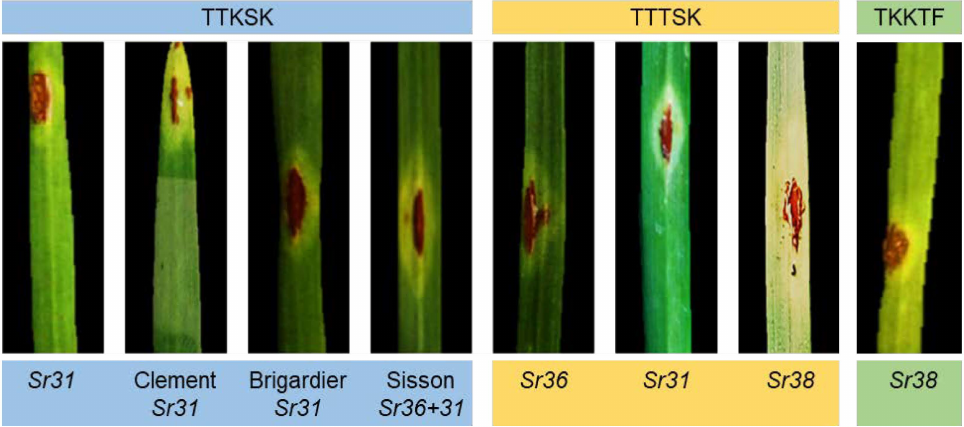
Figure 2. Identified TTKSK, TTTSK, and TKKTF races in the seedling stage and their symptoms on wheat monogenic lines and varieties with stem rust resistance